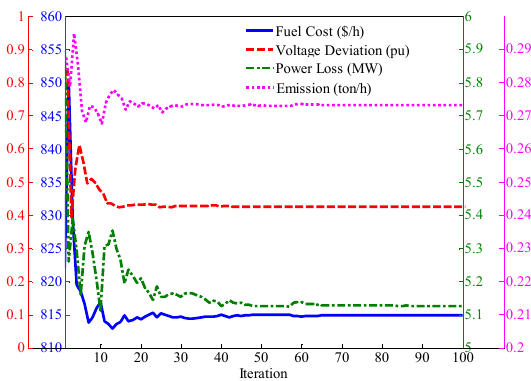
Figure 4. Total cost components convergence curves for case 10.